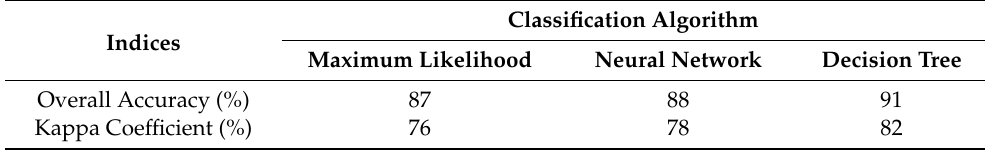
Table 1. Accuracy assessment of land use / cover (LULC) classification for the Hesare-No Basin. Classification Indices